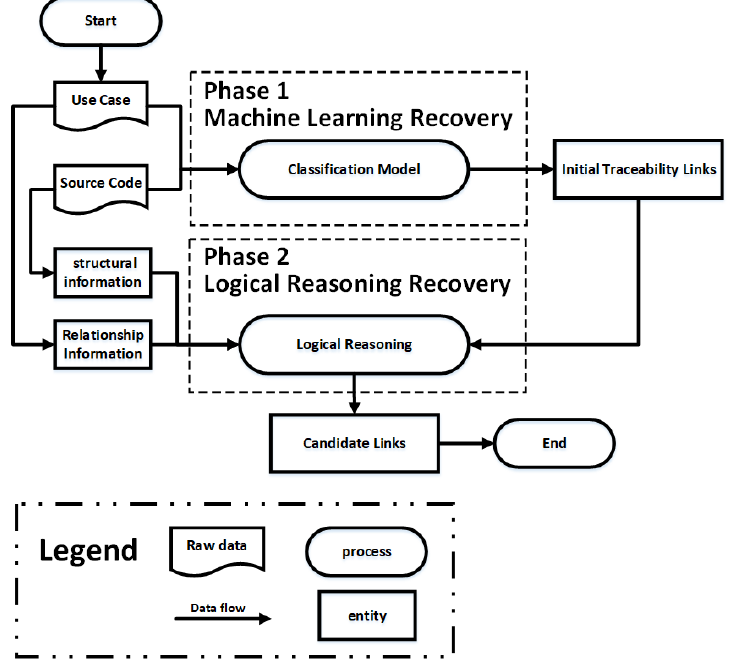
Figure 1. The overall process of our